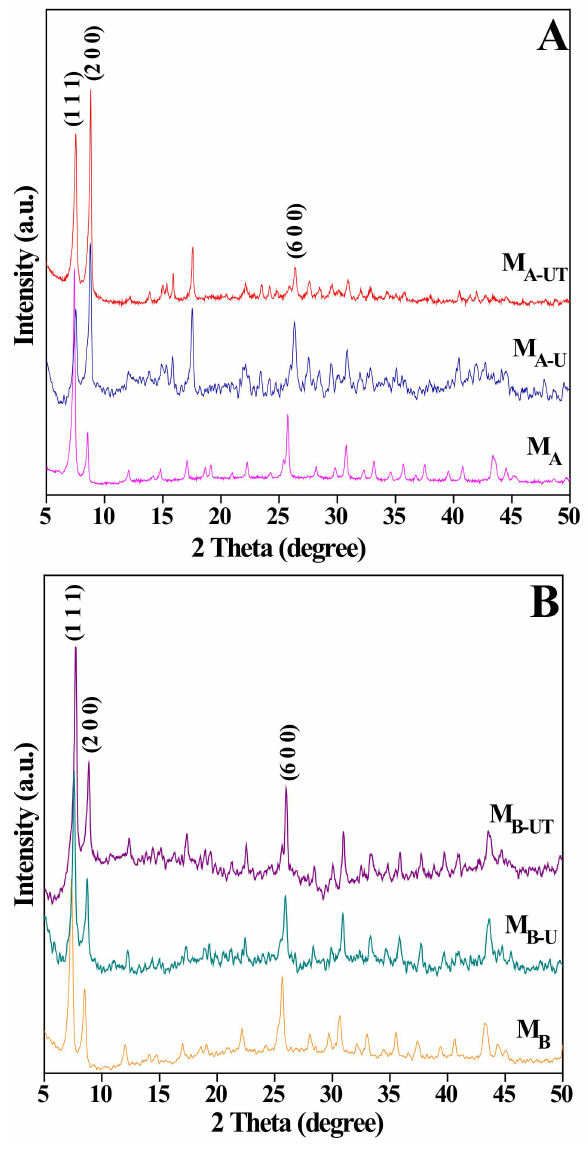
Figure 2. X-ray diffraction patterns. ( A ) UiO-66 magnetic stirring (M A ), UiO-66 ultrasound stirring (M A -U), and ultrasound stirring at 60 ◦ C (M A -UT). ( B ) UiO-66 magnetic stirring (MB), UiO-66 ultrasound stirring (M B -U), and ultrasound stirring at 60 ◦ C (M B